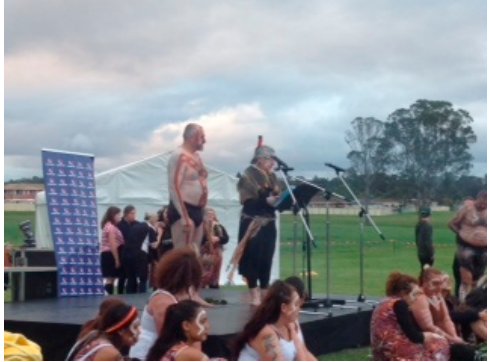
Figure 2. Image: Blacktown Native Institution site—Return-“Ing” to Dharug Custodianship, 13th October, 2018 Image: J. Rey.